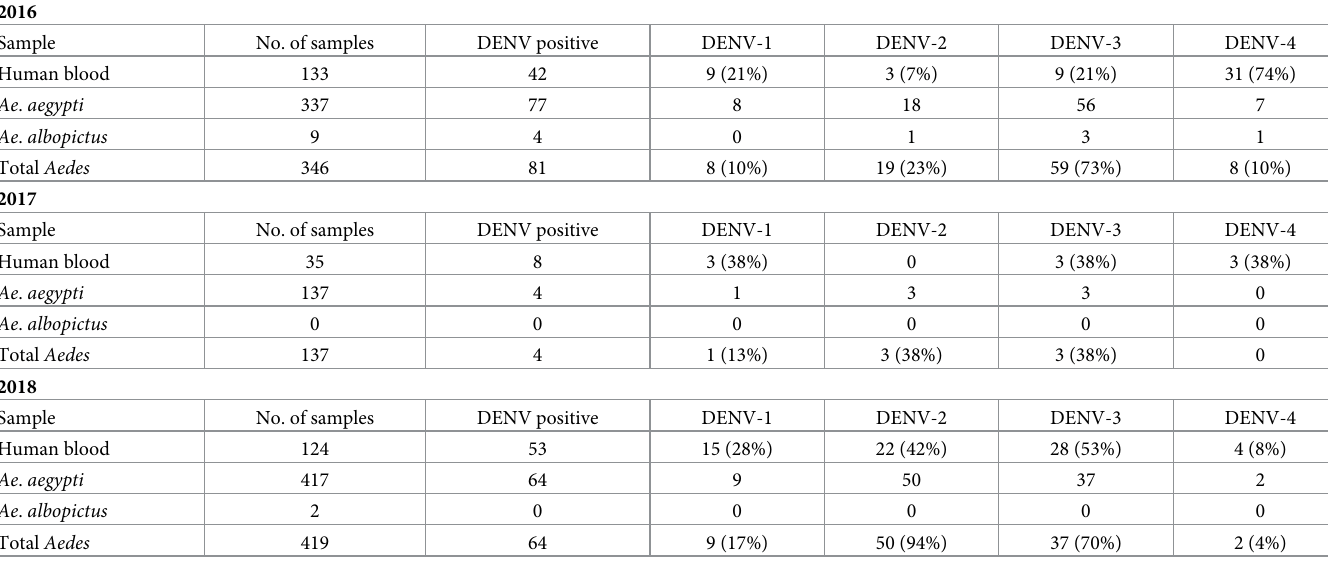
Table 2. Dengue virus infection and serotype distribution in human blood and individual mosquitoes per